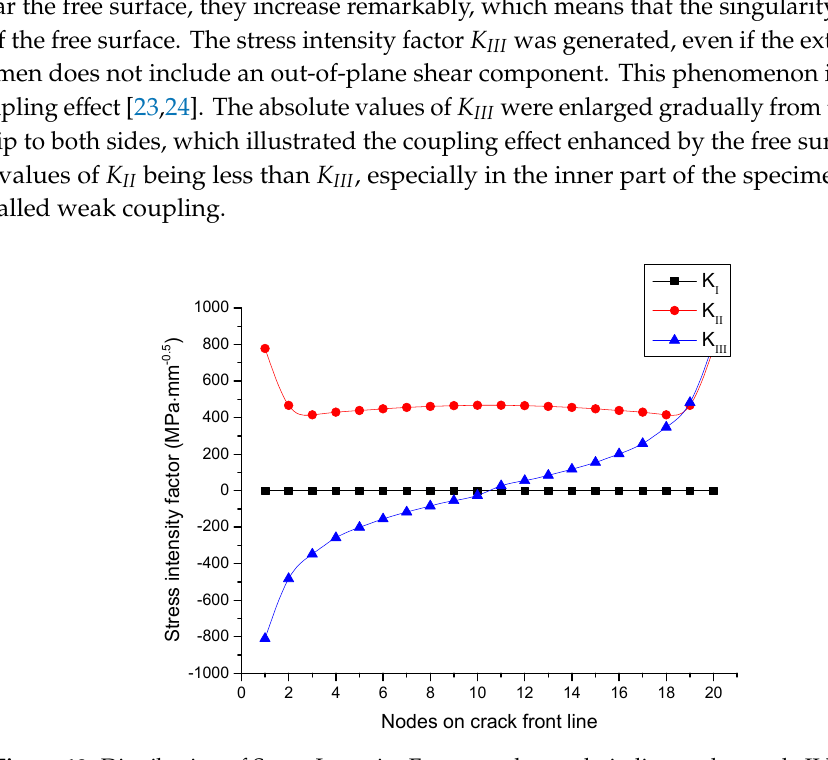
Figure 19. Distribution of Stress Intensity Factor on the crack tip line under mode  loading. 4. Conclusions The energy release rate associated with stress intensity factors under mixed mode loading for aluminum alloy material has been investigated using both a numerical method and theoretical derivation. The present results demonstrate the simpler, accurate calculation process and accurate evaluation of the energy release rate. The following conclusions can be drawn: (1) A relatively simple and precise numerical method was established to evaluate the energy release rate associated with the stress intensity factors under mixed mode loading based on the concept that the energy release rate is equal to the change rate of the energy difference before and after crack kinking. (2) Based on the numerical method, a series of spatial inclined ellipses in Mode I ‐ II and ellipsoids in Mode I ‐ II ‐ III with different propagation angles computed from non ‐ dimensional value